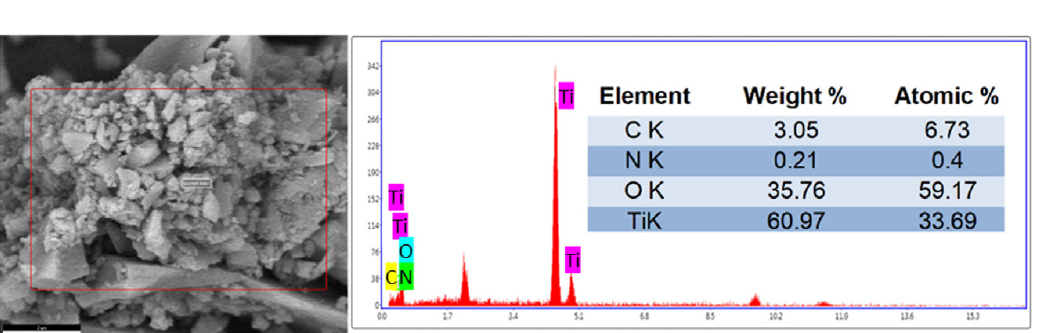
Fig. 4. SEM image and EDX analysis of the N ‐TiO 2 /C nanocomposite.